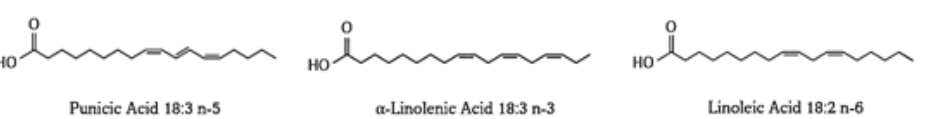
Figure 3. Structure of punicic acid and related isomers α -linolenic acid and linoleic acid. Chemical structures drawn in ChemDraw .